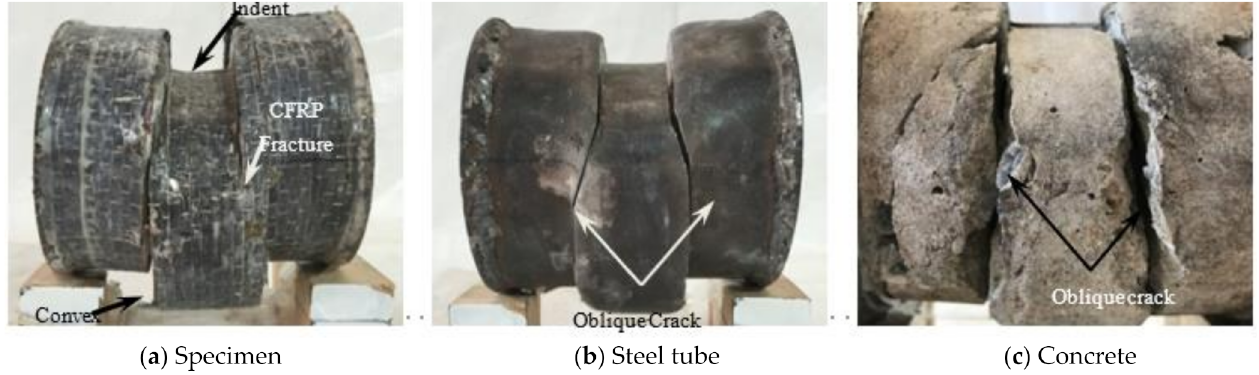
Figure 4. Failure modes.